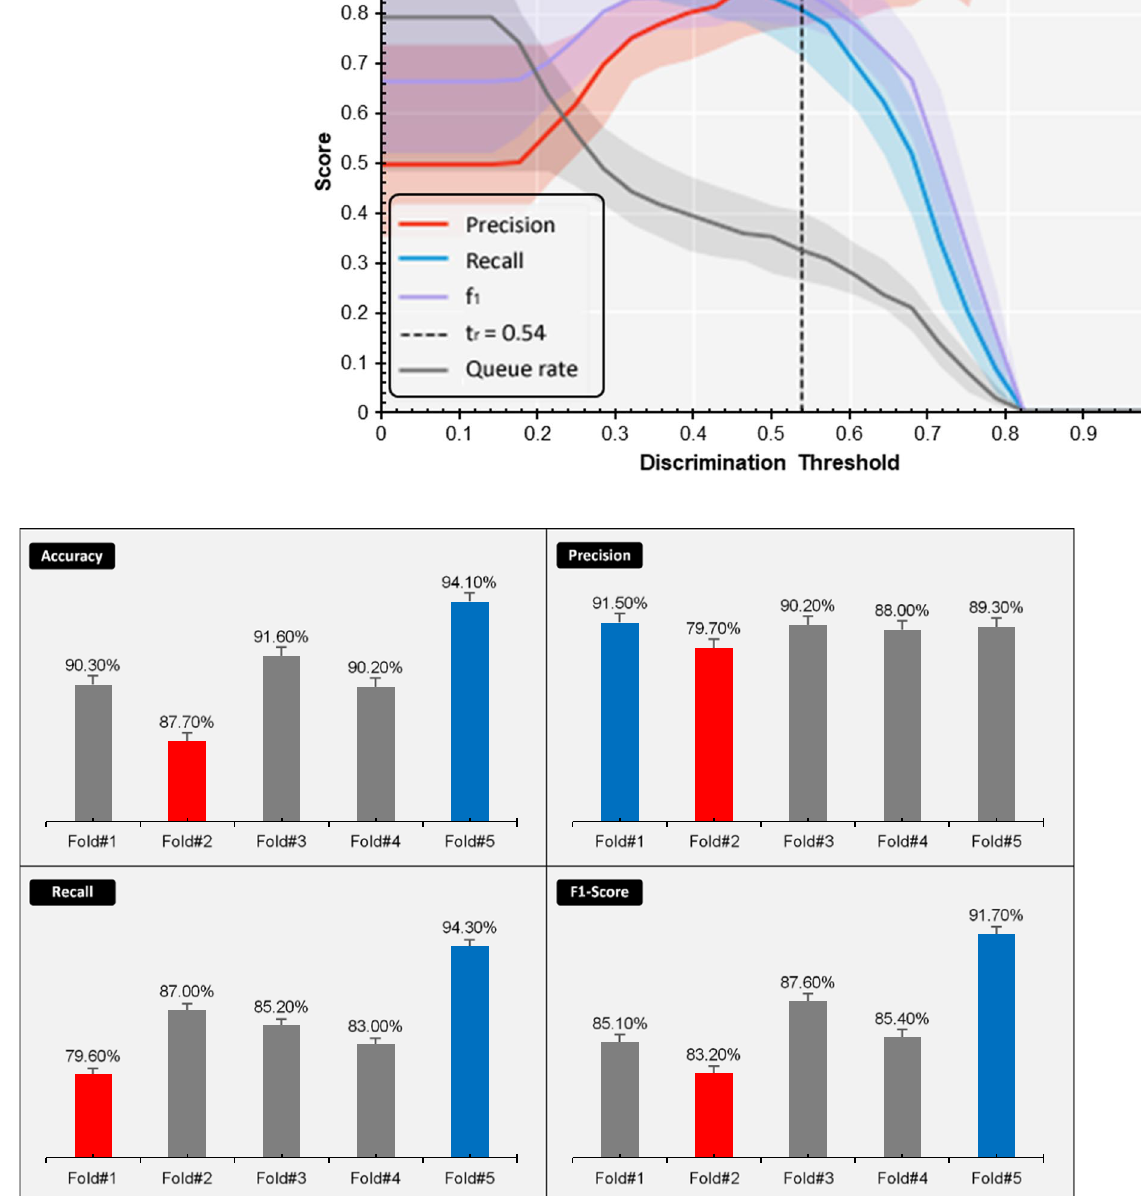
Fig. 5 Fivefold cross-validation of LightGBM + k -NN + Adaboost ensemble